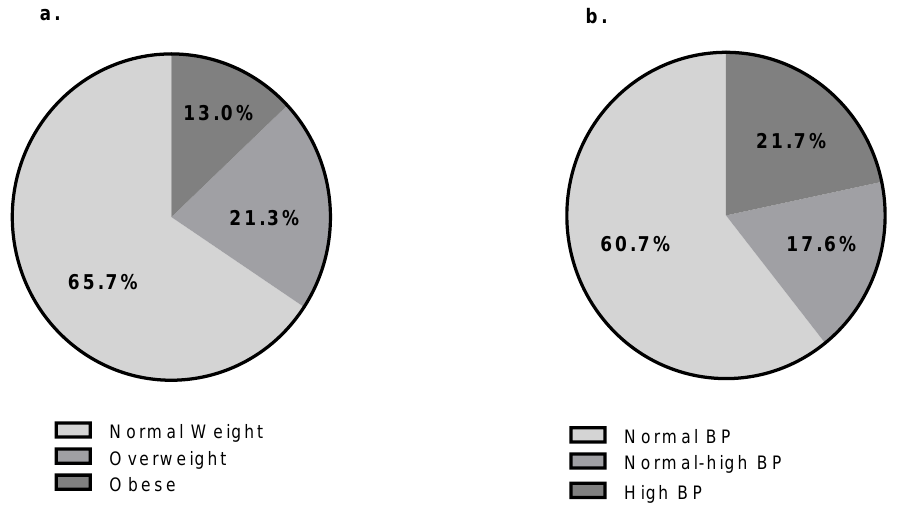
Figure 1. Prevalence of overweight / obese ( a ) and normal high / high blood pressure (BP) ( b ). Legend: “Normal weight”: percentile body mass index (BMI)—age < 85 th ; “Overweight”: 85 th < P percentile BMI—age < 95 th ; “Obese”: percentile BMI—age > 95 th ; “Normal blood pressure (BP)”: percentile SBP and DBP < 90 th ; “Normal-high blood pressure (BP)”: 90 th < percentile SBP or DBP < 95 th ; “High blood pressure (BP)”: percentile SBP or DBP > 95 th .